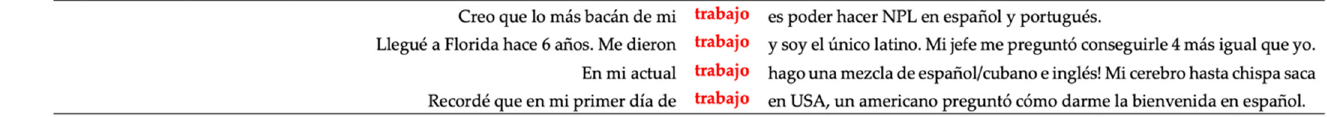
Figure 4. Concordance lines for trabajo that indicate positive attitudes on the status dimension.